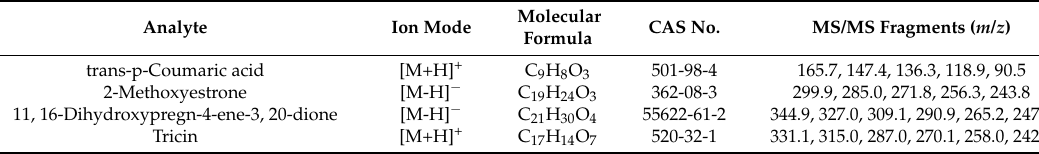
Figure 7. NMR spectra of Tricin. Purified Compound ( 4 ) in DMSO- d 6 solution was conducted NMR analysis. 1 H, 13 C, DEPT90, and DEPT135-NMR spectra are shown in ( A – D ), respectively. Compounds ( 1 )–( 4 ) identified by tandem mass spectrometry (MS 2 ) are listed in Table 1. Table 1. Characteristics of compound ( 1 )–( 4 ) identified by tandem mass spectrometry.